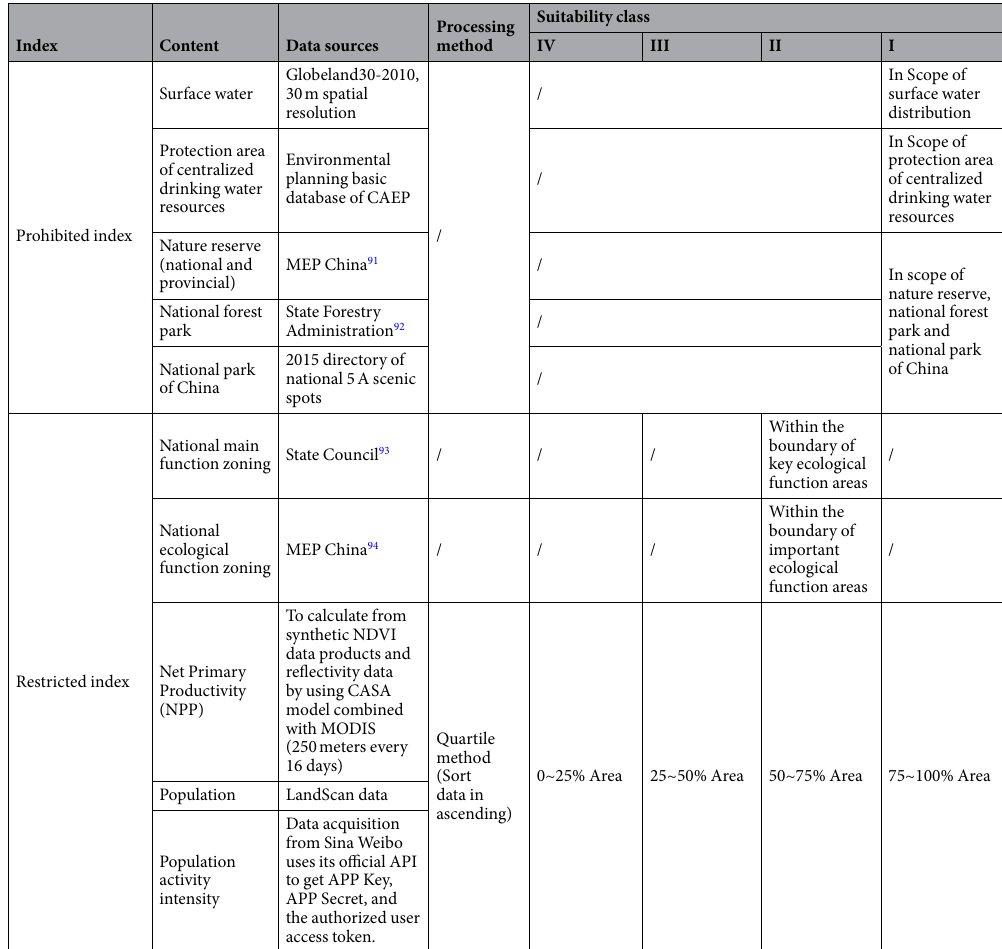
Table 3. Basic data sheet. Note: Suitability class I covers prohibited indexes for CCS site selection, i.e. it is prohibited to construct CCS projects in areas with this suitability class; Suitability classes II, III and IV indicate environmental suitability of CCS site selection successively